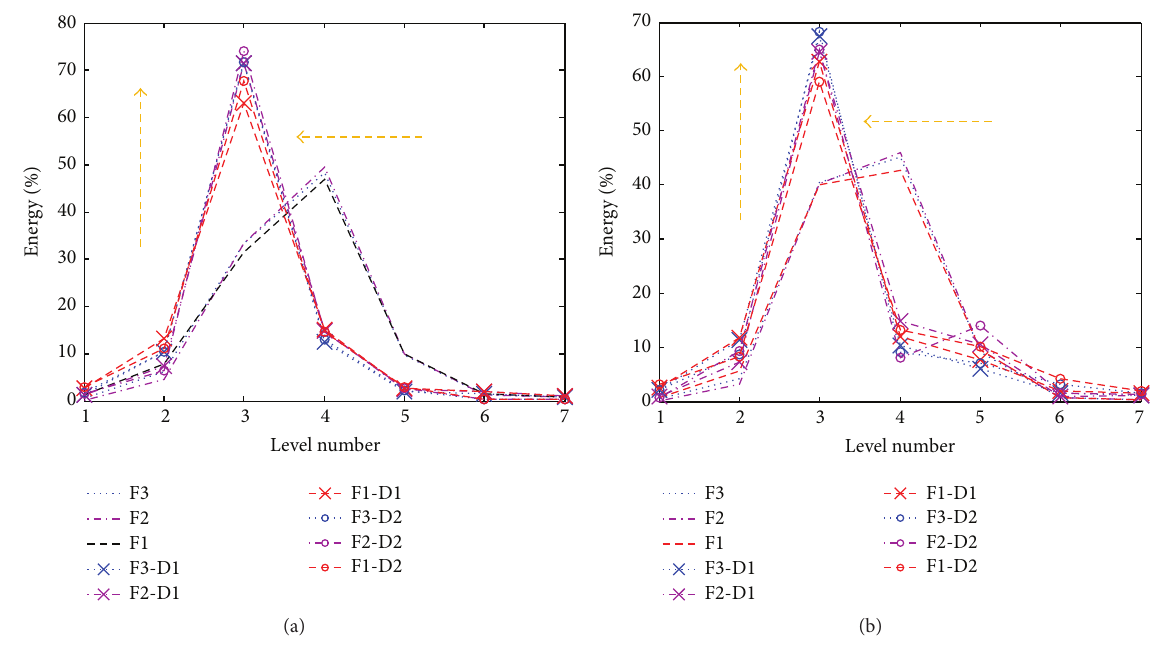
Figure 9: Energy distributions at each decomposition level of (a) regular and (b) irregular buildings under different damage